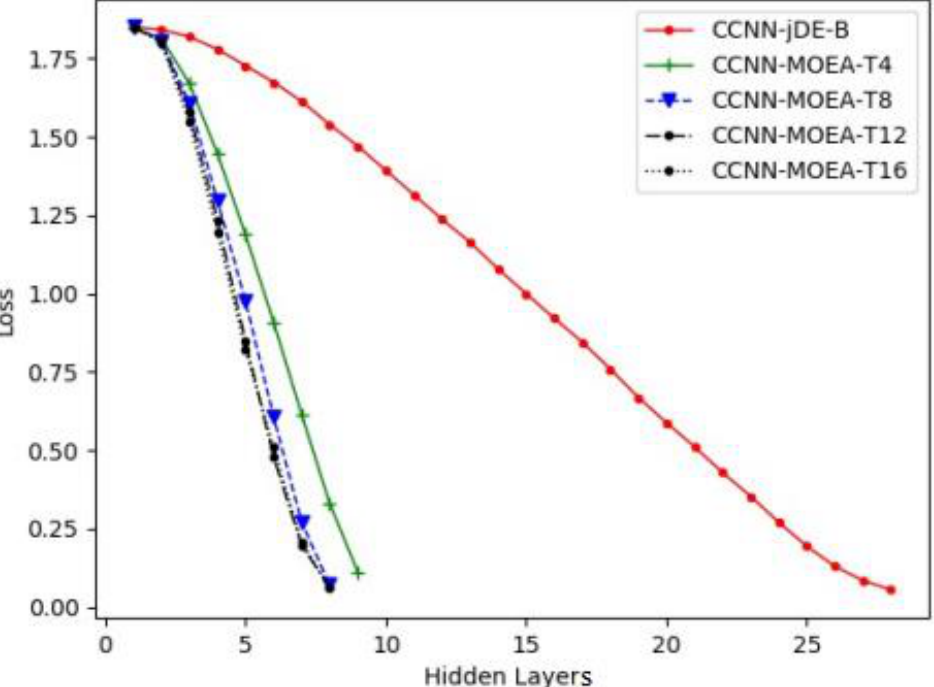
Figure 8. Each algorithm drops the loss value on the four spirals classification problem.